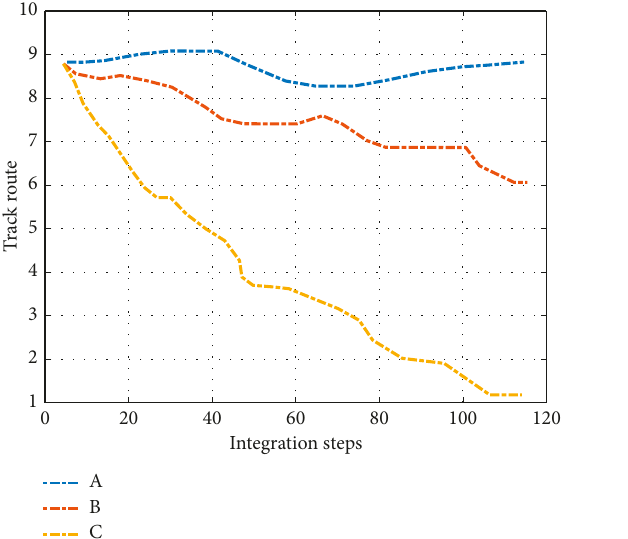
Figure 4: Optimized badminton backcourt stroke path planning results.